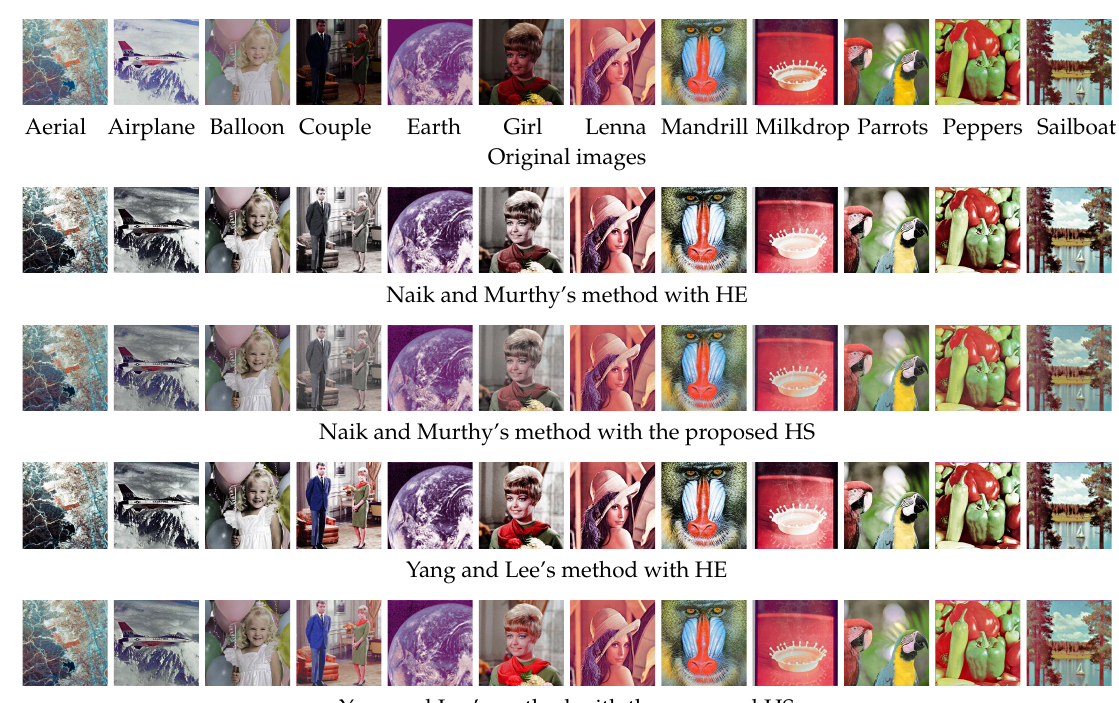
Figure 3. Results of hue-preserving color image